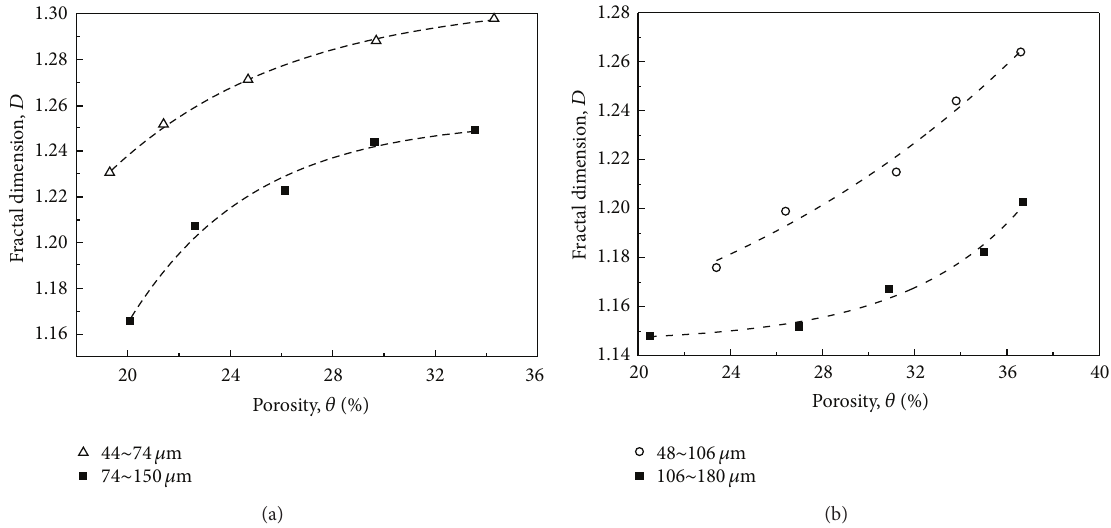
Figure 2: Fractal dimension versus porosity: (a) irregular powder and (b) spherical powder.